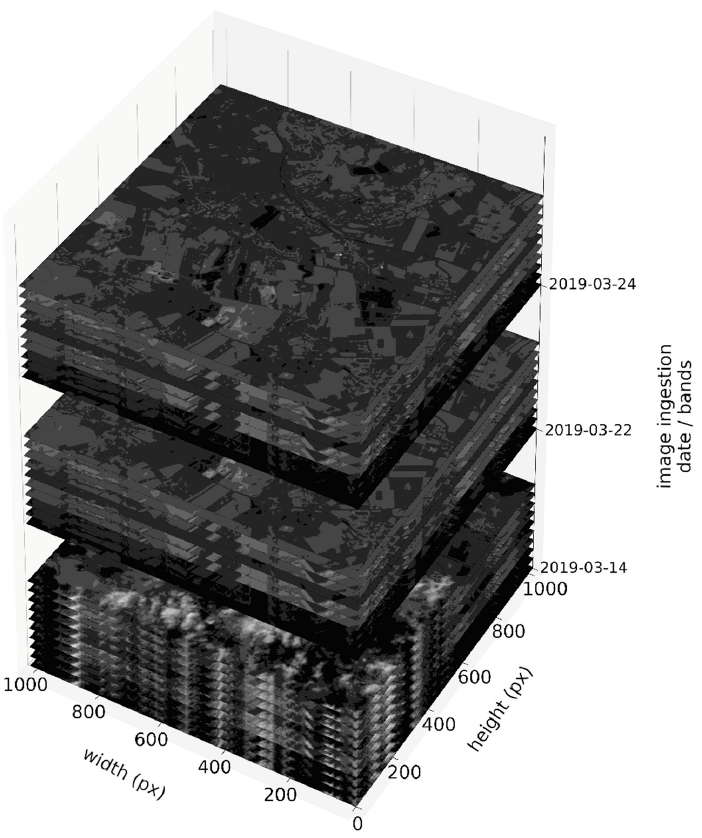
Figure 1. Visualization of how image bands stack in time, as stored in an EOPatch (as the DATA FeatureType).